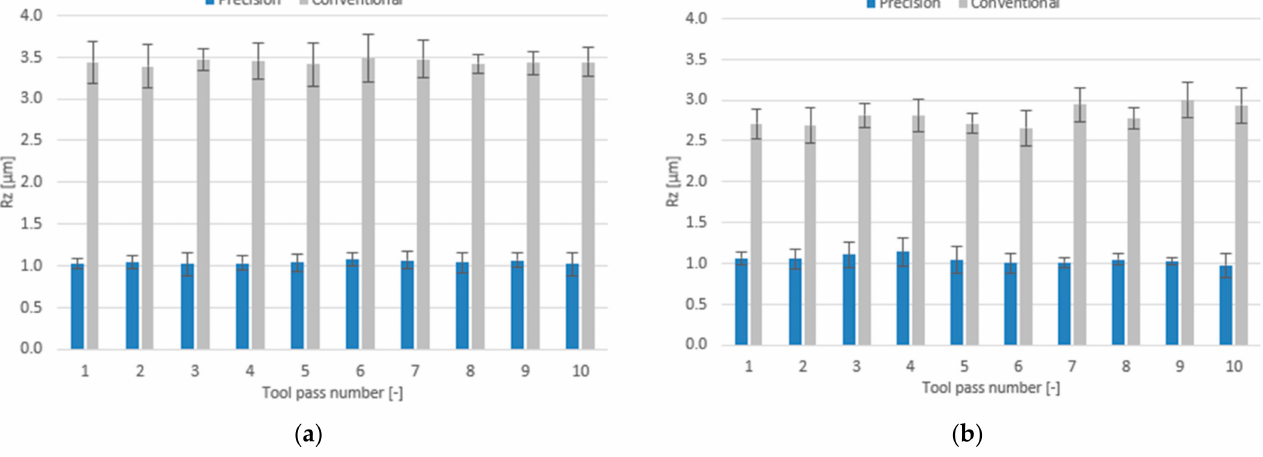
Figure 19. Milling conditions versus surface roughness parameter Rz in the milling process conducted using a tool coated with: ( a ) TiB 2 and ( b )